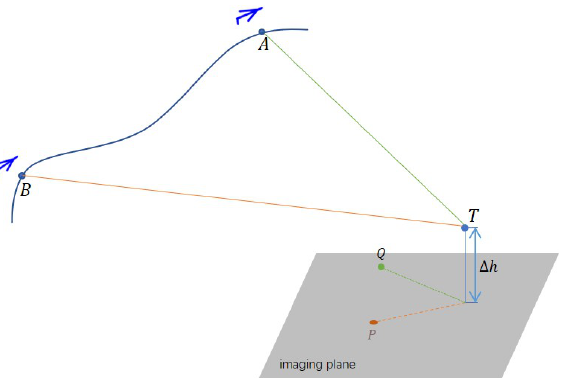
Figure 1. The imaging diagram under two viewing angles. T is a target above ground plane. P and Q are projection points from different viewing angles.